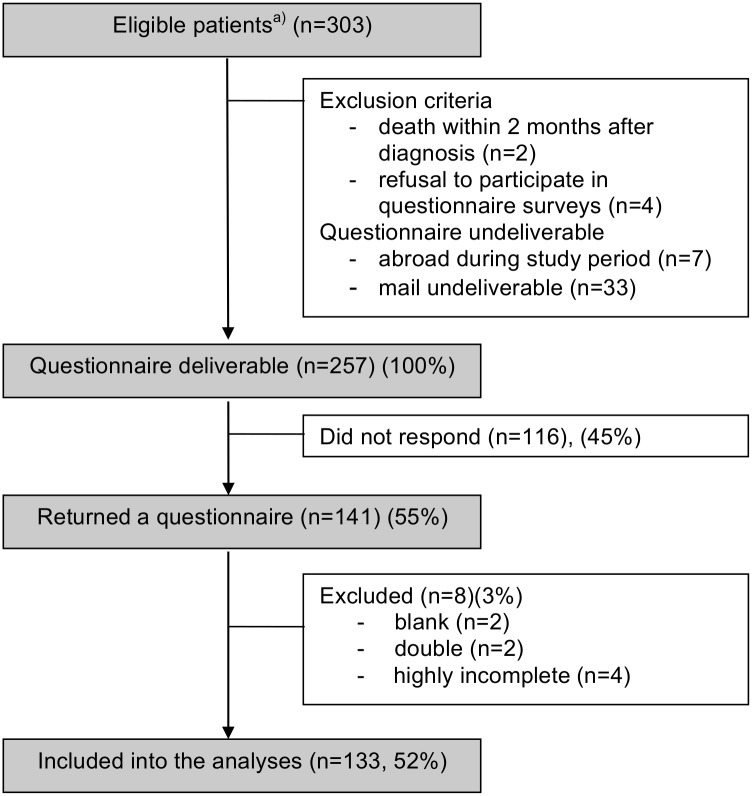
Inclusion process and eligibility of study participants.
a) Diagnosed between January 1st 2002 and December 31st 2011, aged 0 to 18 years at diagnosis, treated at the Division of Pediatric Hematology/Oncology at the University Children’s Hospital Bern, Switzerland.